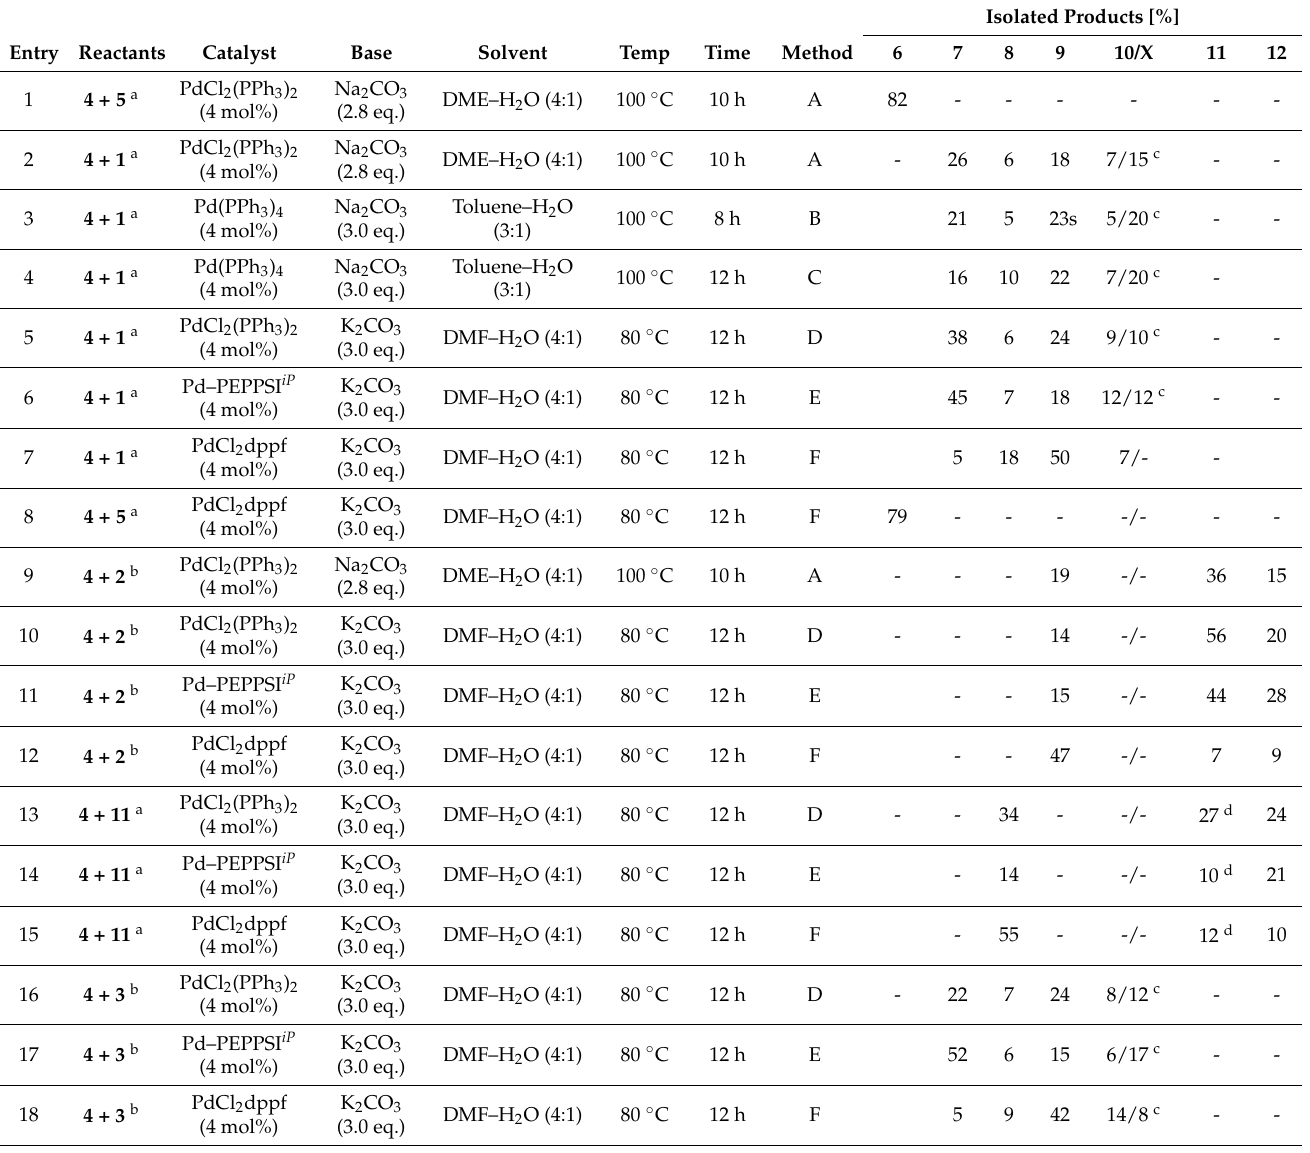
Table 1. Conditions and product distributions of the SM reactions of 4,5-dibromo-2-methylpyridazin- 3(2 H )-one 4 with phenylboronic acid 5 , and ferrocene-containing boronates 1–3